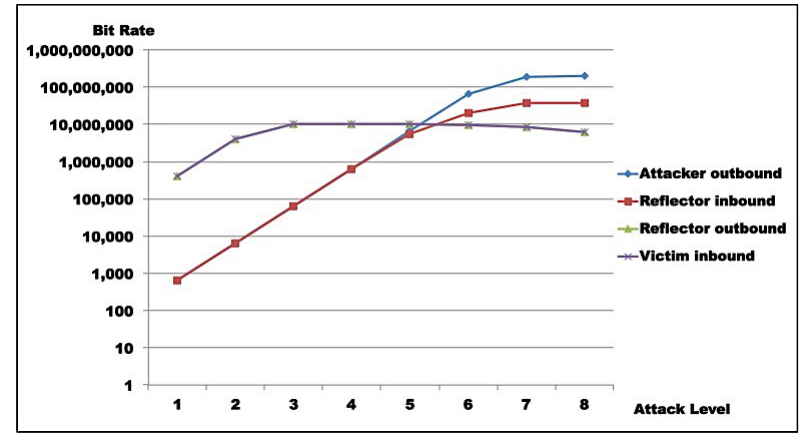
Figure 11. Test 1: Traffic rates by attack level (Bit/s).